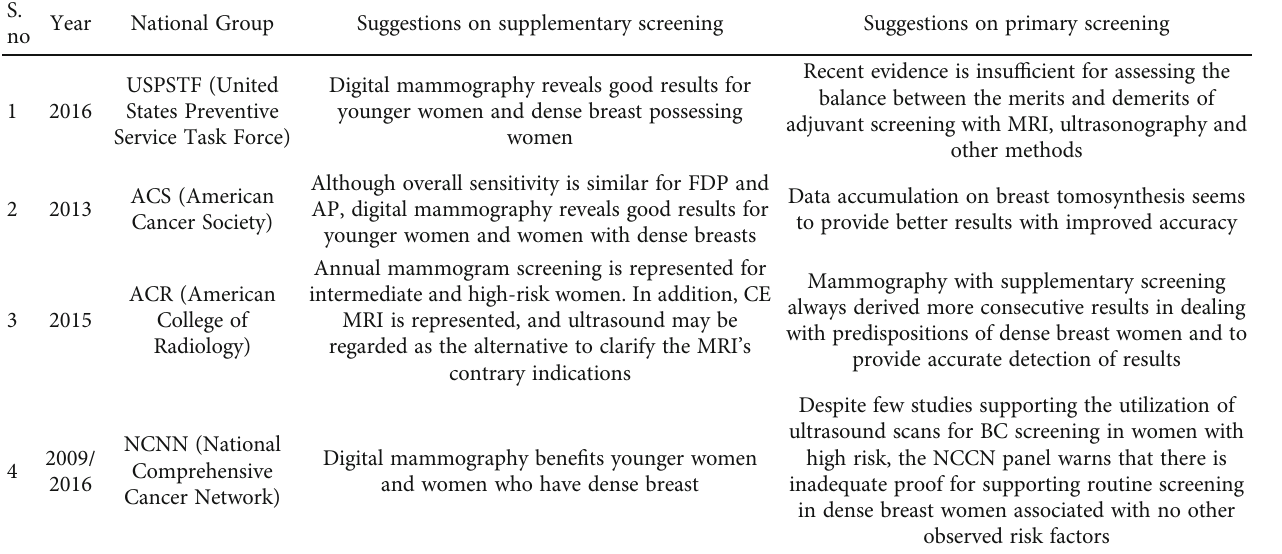
Table 2: The screening modality for dense breast women is routine mammography.